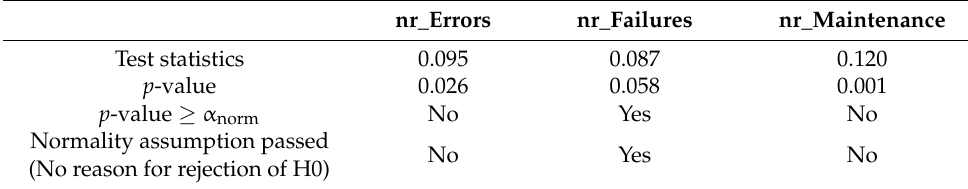
Table 2. Verification of data normality assumption using the Lill test, α norm =